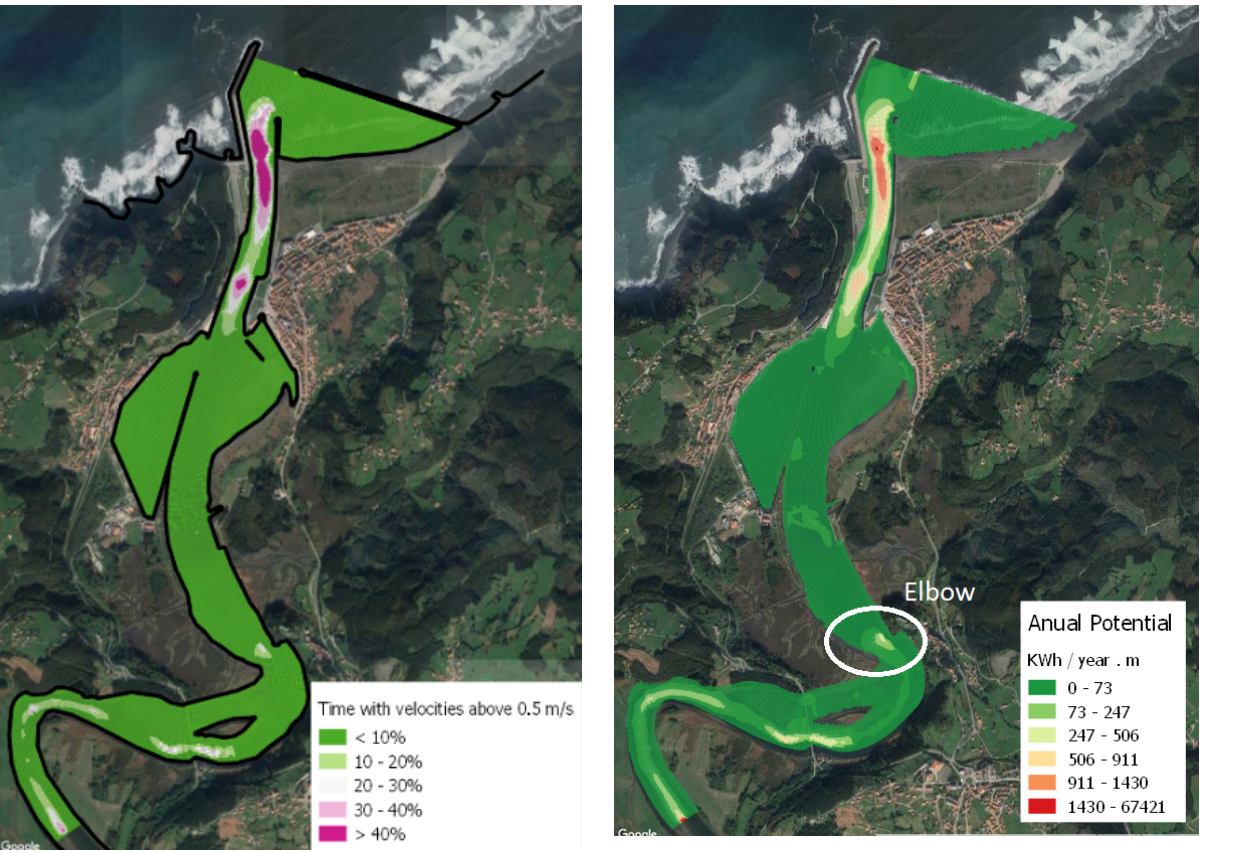
Figure 4: Percentage of time with velocity above 0.5 m/s.